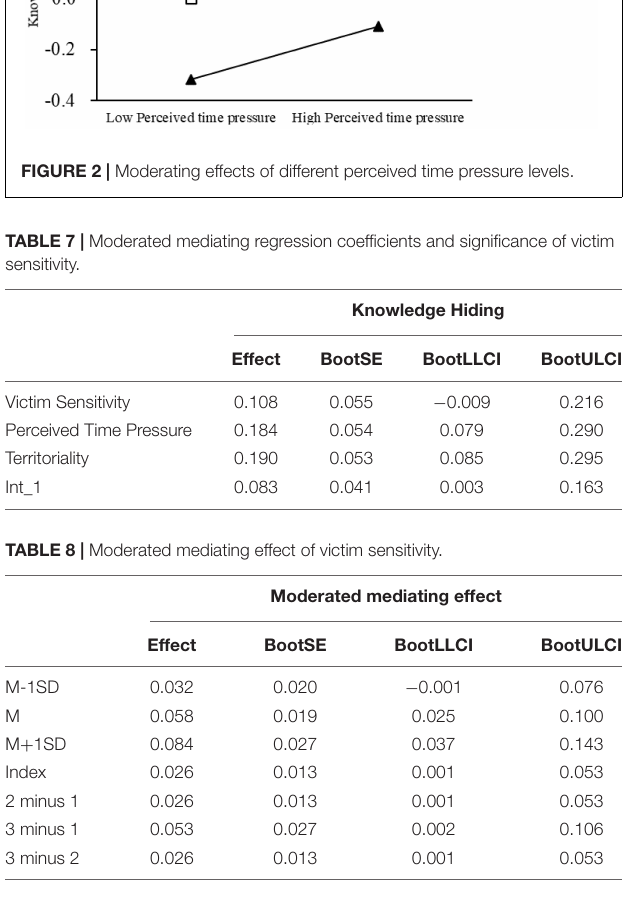
FIGURE 3 | Slope diagram of the mediating effect of victim sensitivity.